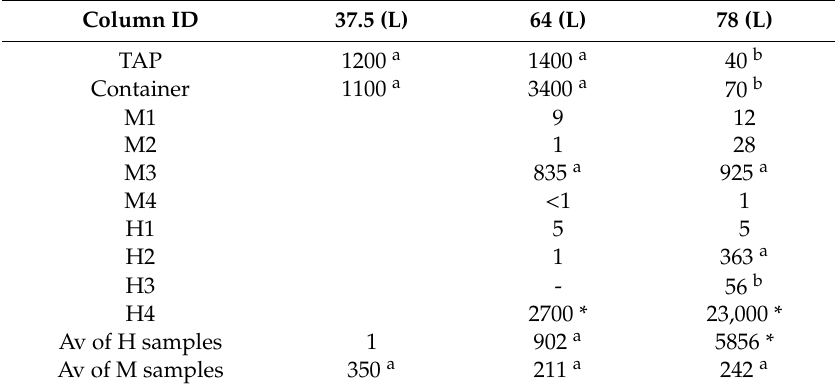
Table 4. Removal of total bacteria count by fresh micelle–clay granules: number of emerging bacteria (CFU per mL) after filtration of given volumes α .